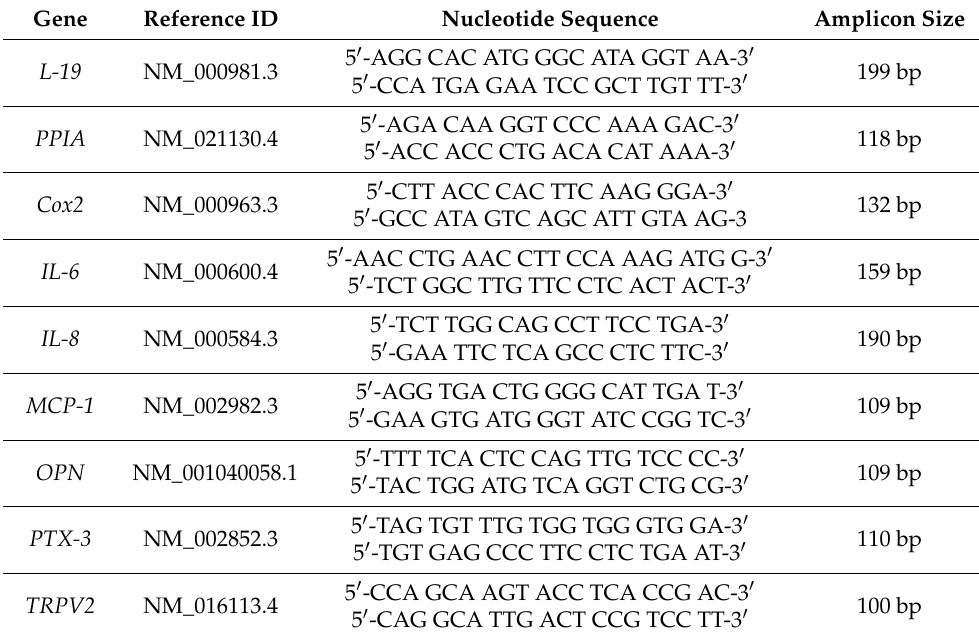
Table 1. Oligonucleotide primer sequences and corresponding amplicon